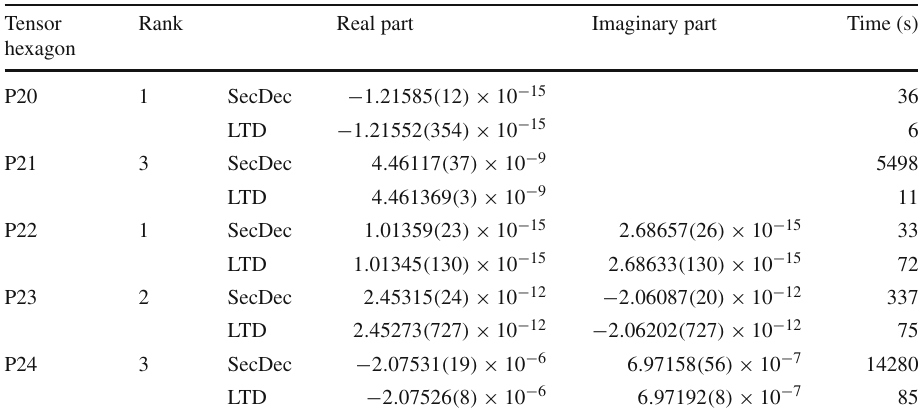
Table 5 Tensor hexagons involving numerators of rank-one to three